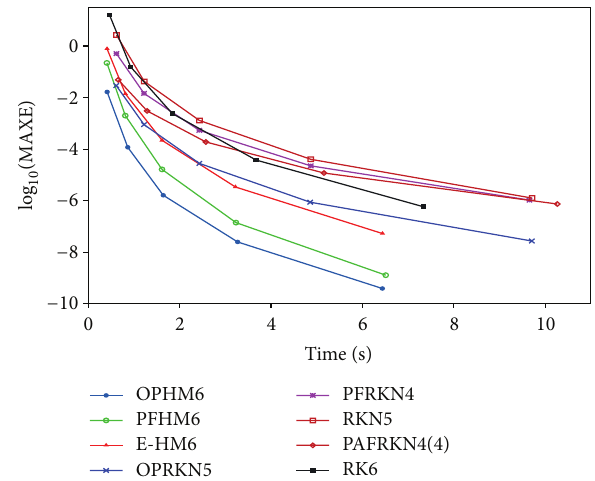
Figure 14: The efficiency curves of the optimized order six method and their comparisons for Problem 8 with 𝑡 0.125/2 𝑖 , 𝑖 = 1,...,5